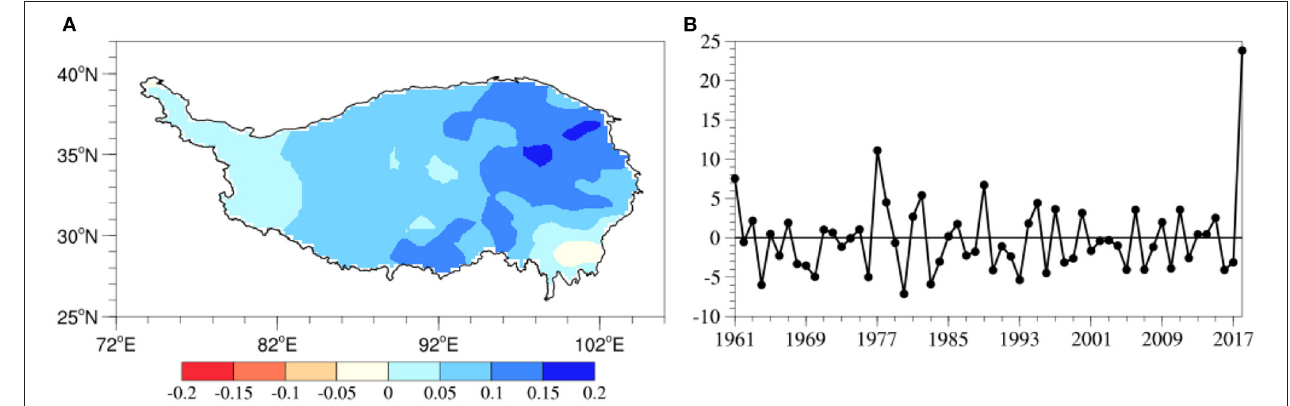
FIGURE 1 | The EOF-1 (A) mode and detrended PC1 (B) of early winter snowfall on